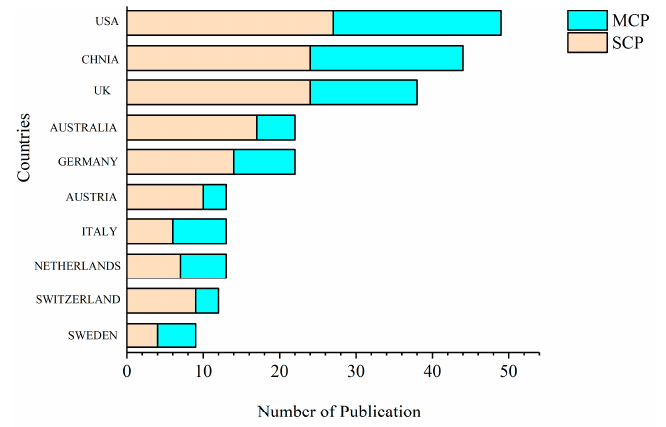
Figure 5. Top 10 corresponding authors’ nationalities regarding the research of SDGs related to forests and forestry. SCP indicates a single-country publication, and MCP indicates a multiple- country publication.